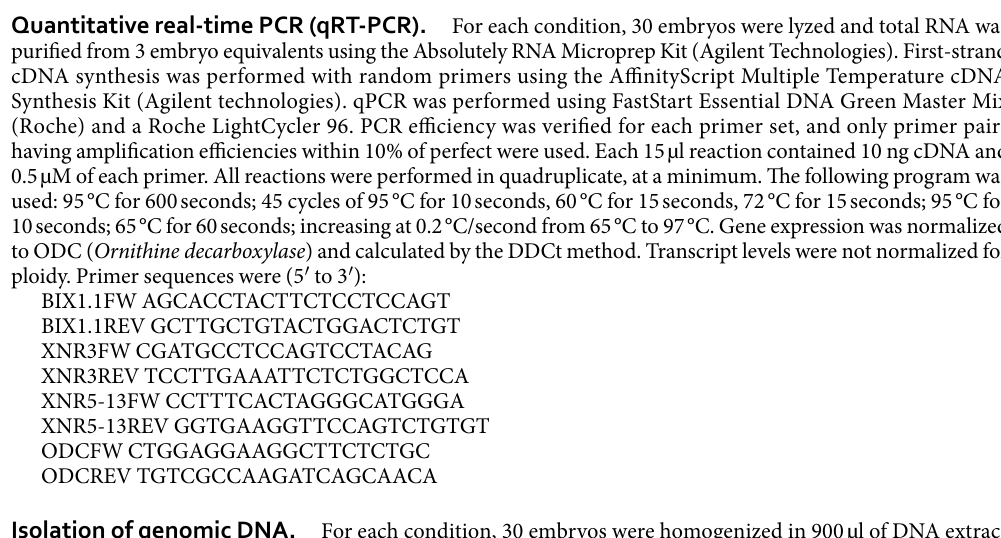
For each condition, 30 embryos were homogenized in 900 µ l of DNA extrac- tion buffer (10 mM Tris pH 8.0, 0.2 mM EDTA, 50 µ g/ml RNase A, 0.5% SDS) and incubated at 37 °C for 1 hour. Proteinase K was added at 100 µ g/ml and samples were incubated at 50 °C for 2 hours. Samples were extracted in